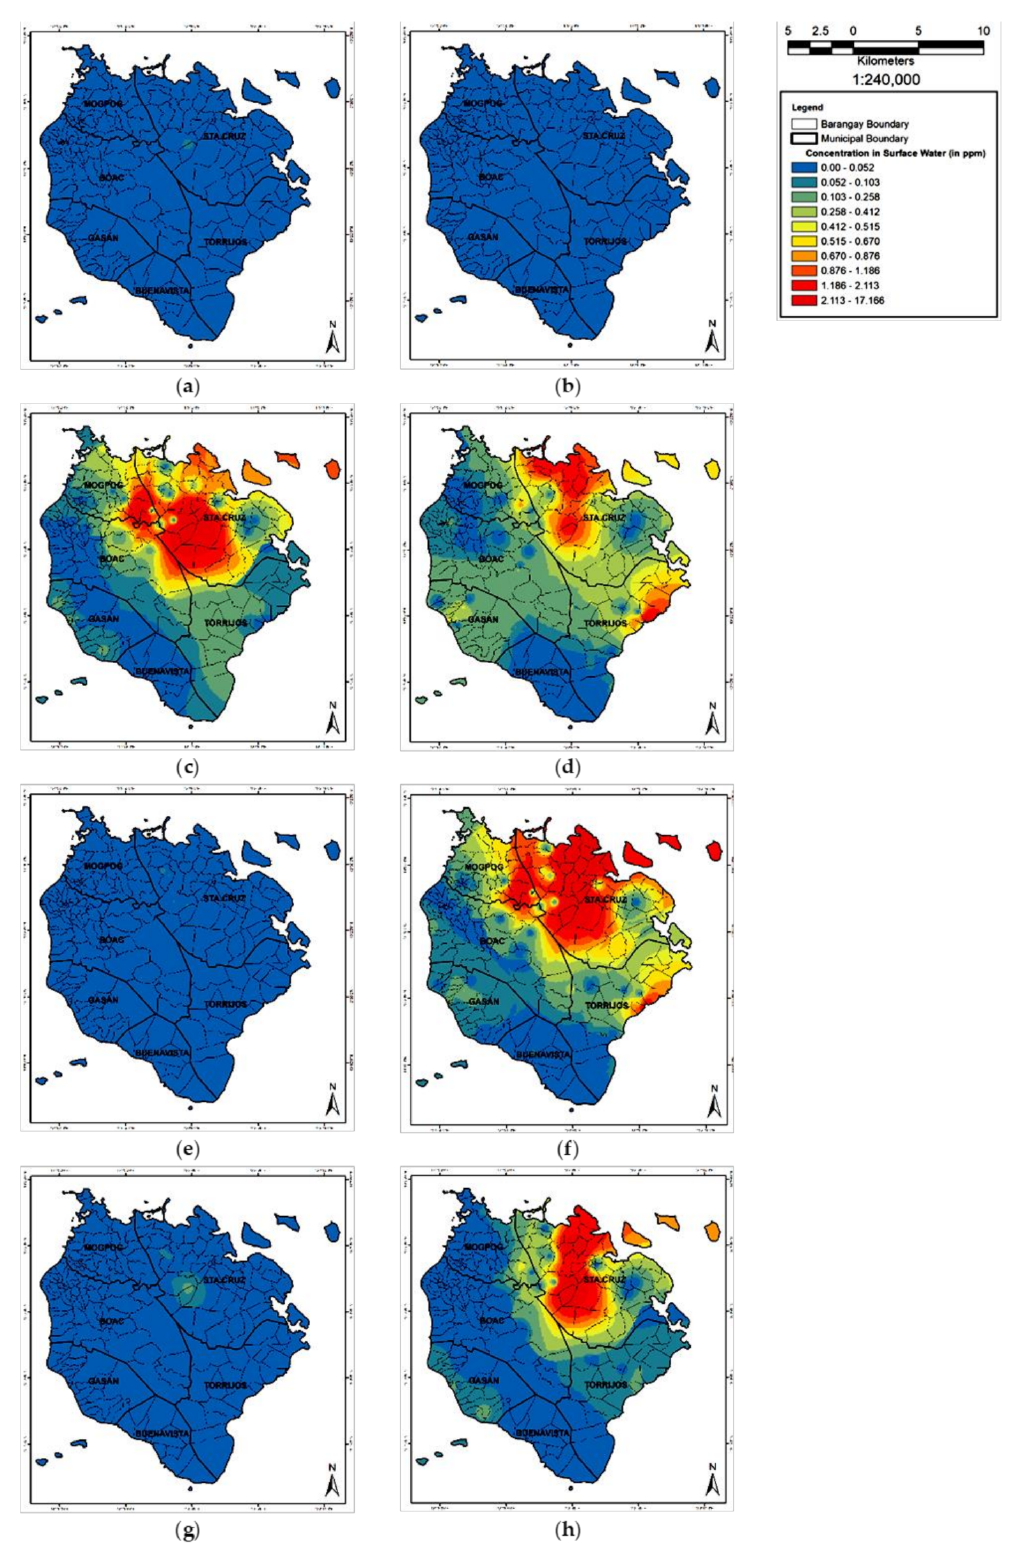
Figure 2. Surface water spatial distribution of metals concentrations in Marinduque: ( a ) Cd, ( b ) Cr, ( c ) Cu, ( d ) Fe, ( e ) Pb, ( f ) Mn, ( g ) Ni, and ( h )